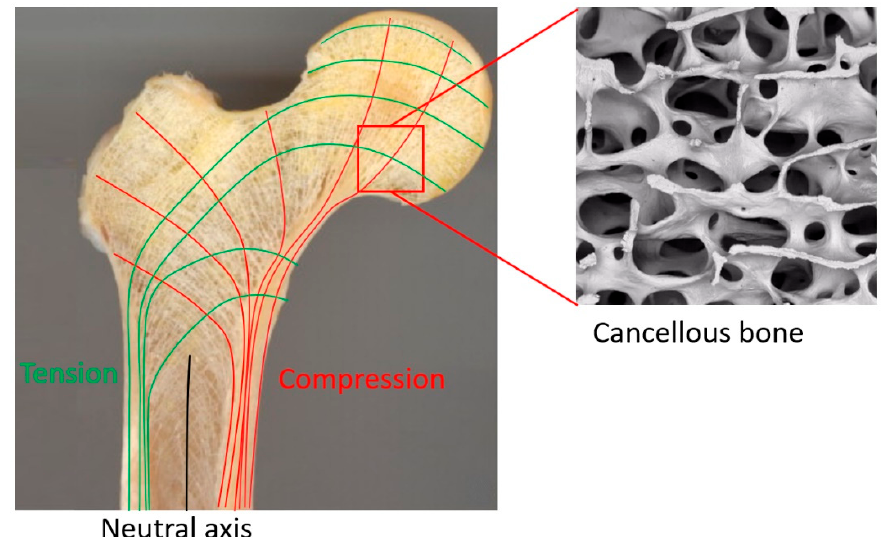
Figure 5. Cortical and cancellous bone; image adapted from [157,158] by kind permission of Alan